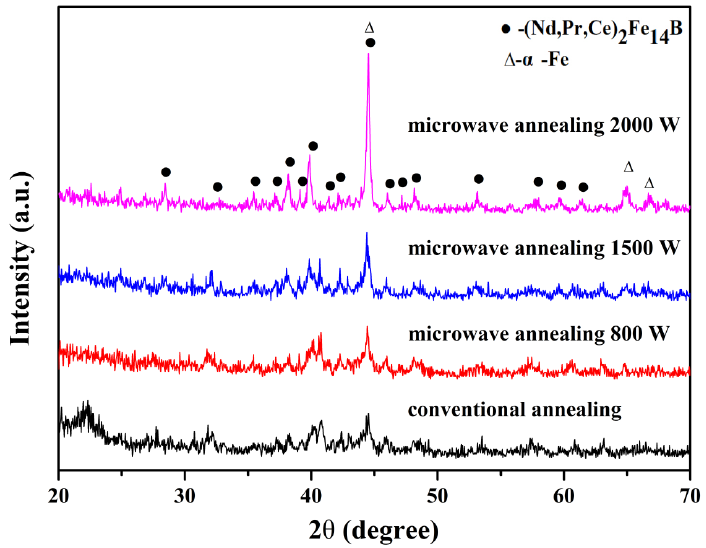
Figure 4. X-ray diffraction patterns of the annealed (Nd 0.525 Pr 0.175 Ce 0.3 ) 9 Fe 64.5 Co 3 Cu 0.5 Ti 1 B 22 ribbons under different conditions.